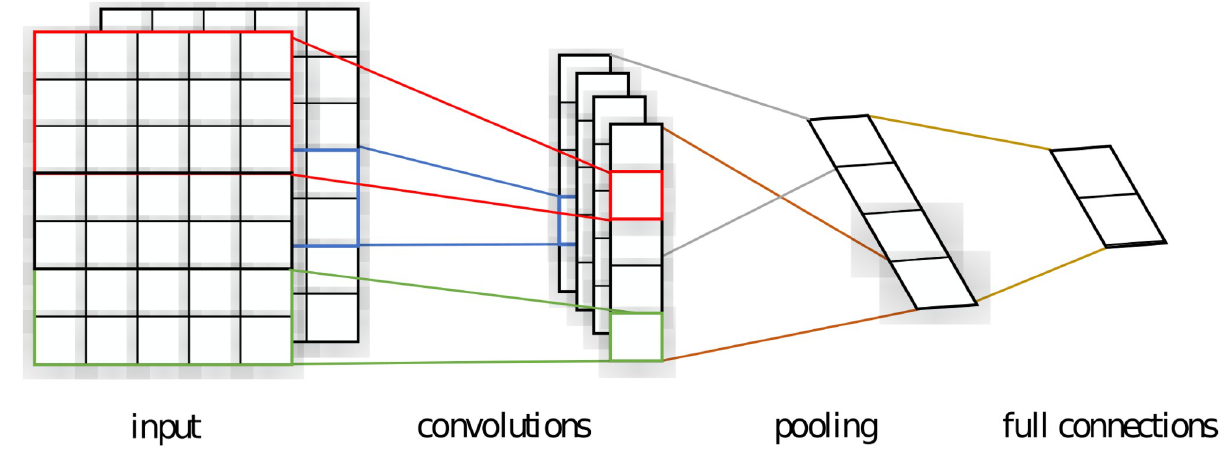
Fig 2. Framework of TextCNN